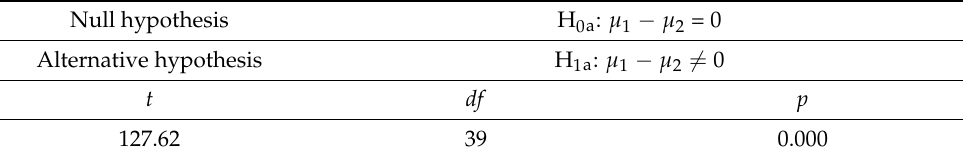
Table 24. Two-sample t -test for sound intensity level